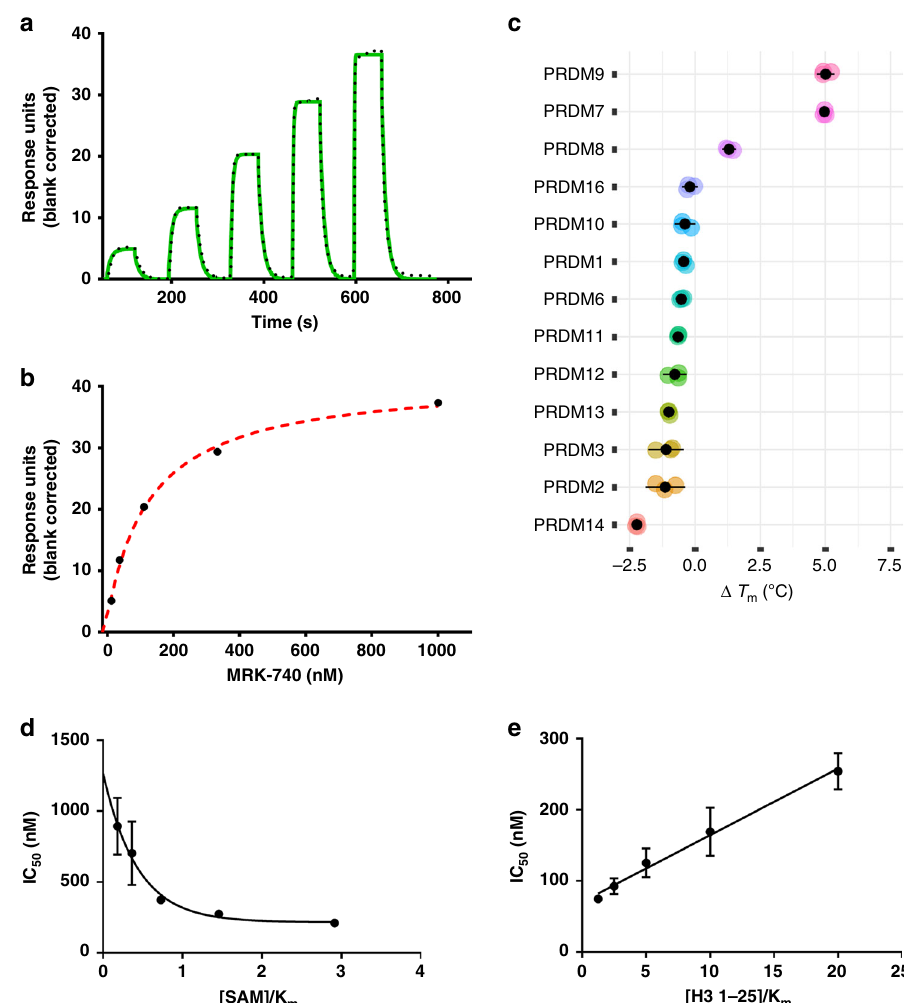
Fig. 2 Orthogonal con fi rmation of MRK-740 binding to PRDM9. Binding af fi nity of MRK-740 was determined using SPR in the presence of 350 µ M SAM (5xK m SAM , 70 ± 10 µ M). a A representative sensorgram (solid green) is shown with the kinetic fi t (black dots). From kinetic fi tting, a K d value of 87 ± 5 nM, + 6 M − 1 S − 1 and k − 1 were obtained from quadruplicate experiments ( n = 4). b The steady state response (black circles) k on of 1.2 ± 0.1 × 10 off of 0.1 ± 0.01 s obtained from A is shown with the steady state 1:1 binding model fi tting (red dashed line). Biotinylated PRDM9 (amino acids 195 – 415) was immobilized on the fl ow cell of a SA sensor chip in 1x HBS-EP buffer, yielding 5700 RU. Using the buffer with 0.5% DMSO, 350 µ M SAM and single cycle kinetic with 60